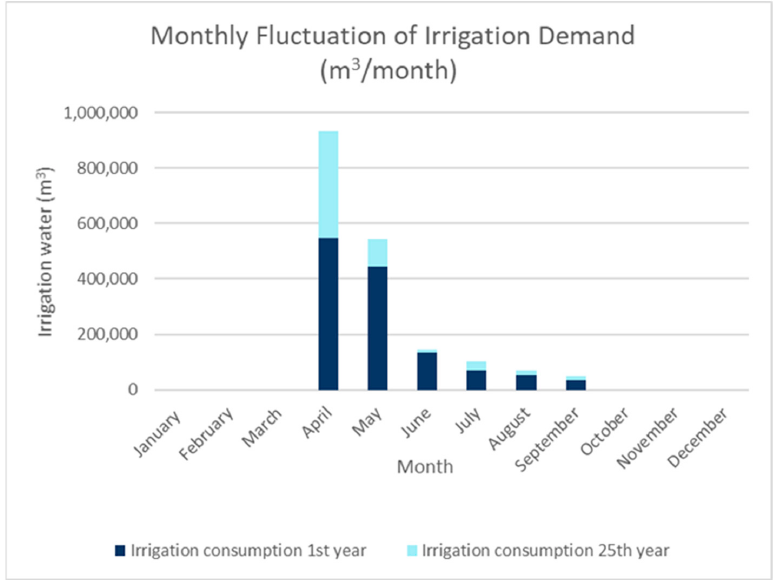
Figure 5. Monthly fluctuations of irrigation demand for the 1st and 25th years of the HRES. The energy needs of Lemnos are fully covered by the APS, with a total installed ca- pacity of 23.6 MW. The energy consumption data from 2016 to 2020, with a monthly step, are obtained from the Hellenic Electricity Distribution Network Operator (HEDNO). The average monthly demand for the year 2020 is presented in Table 1.